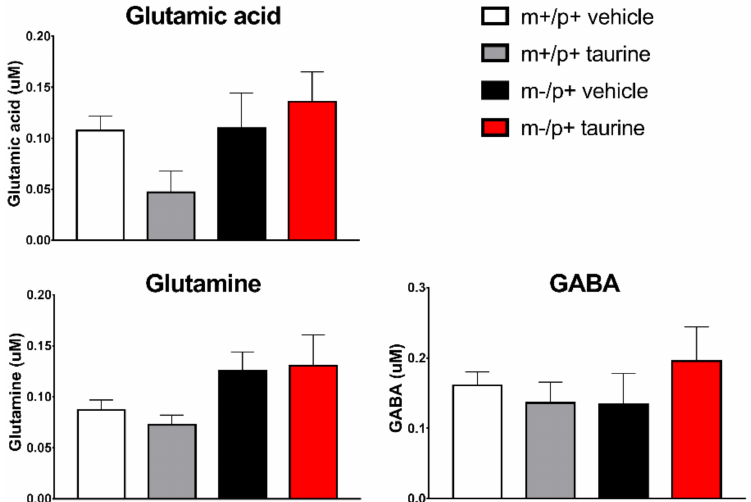
Figure A1. Measurements of neurotransmitters in whole brains evidenced no statistical differences between groups. HPLC experiments on whole mouse brain were carried out to quantify levels of Glutamic acid, Glutamine and Gamma AminoButyric Acid (GABA). Number of mouse